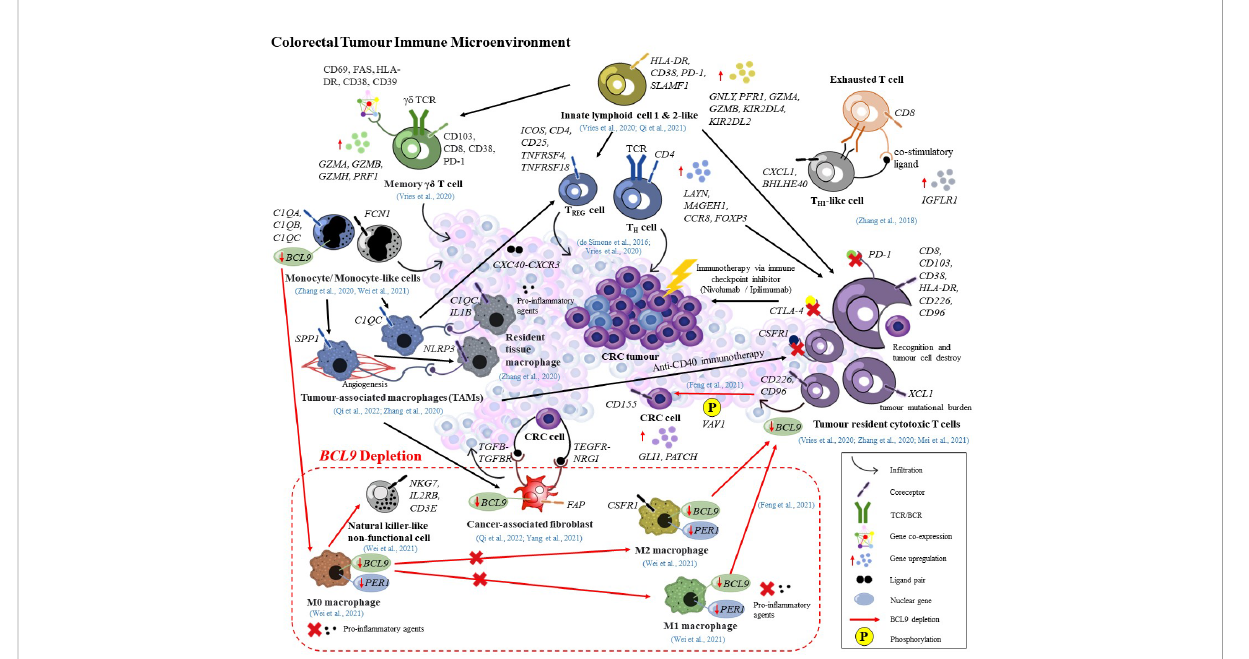
FIGURE 1 Potential immune-based precision medicine targets governed by